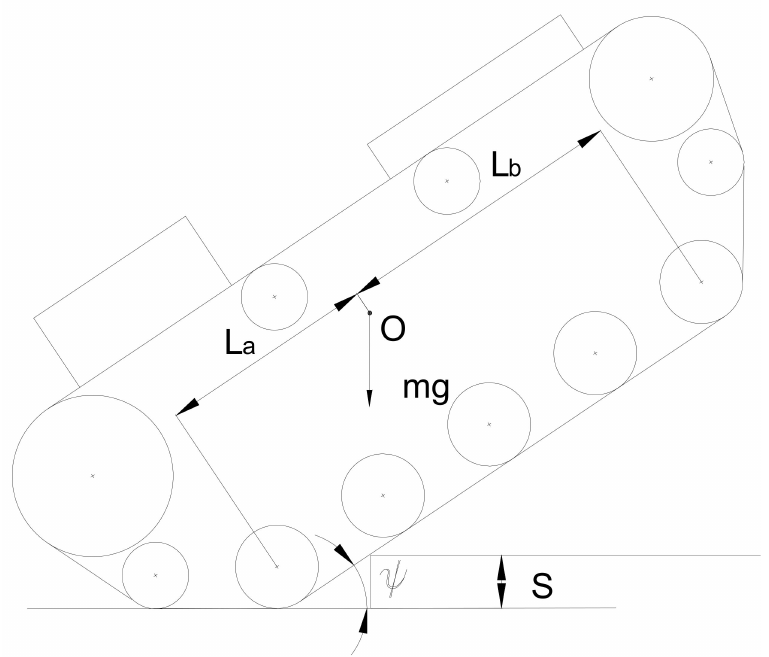
Figure 14. Robot vertical obstacle crossing limit position.